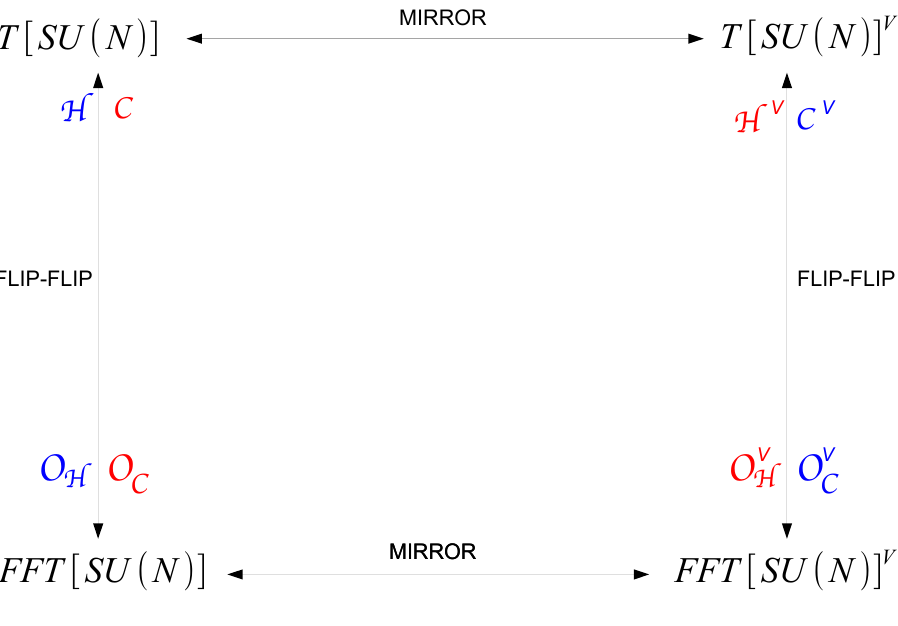
Figure 3 . Duality web for T [SU( N